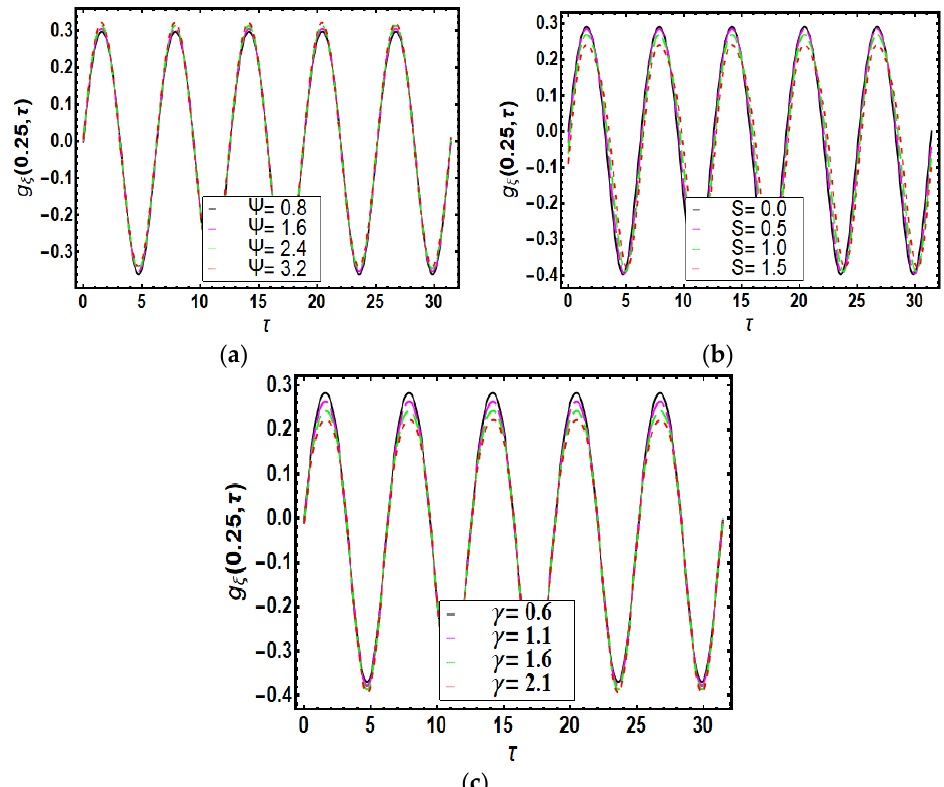
Figure 5. ( a ) Effects of Ψ on g ξ . ( b ) Effects of S on g ξ . ( c ) Effects of γ on g ξ .